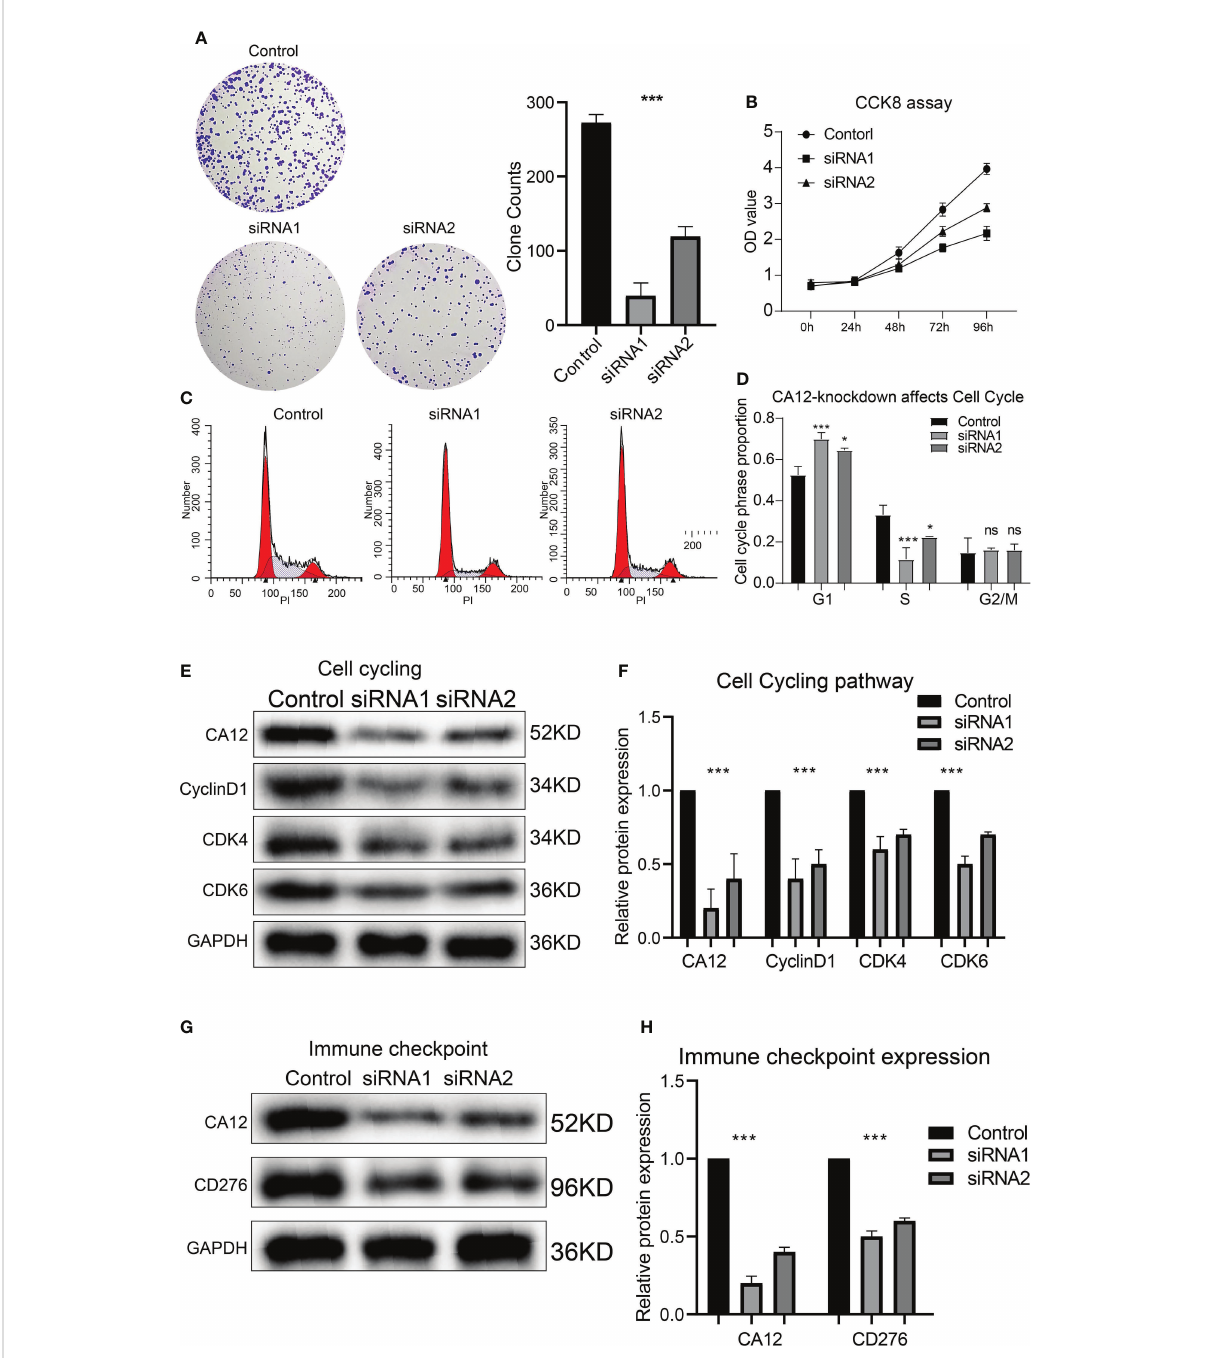
FIGURE 9 Roles of CA12 knockdown in UM cell growth and immune checkpoint expression. The images and the quanti fi cation results of clone formation assay (A) and the results of CCK8 assay (B) for the CA12-knockdown experiments. The cell cycle fl ow cytomatrix results (C) and the comparison of G1, S, and G2/M phases proportion (D) between control and siRNA-knockdown groups. The bands of G1 phase protein expressions (E) and their quanti fi cation comparison (F) between control and siRNA-knockdown groups. The bands of CD276 protein expression (G) and its quanti fi cation comparison (H) between control and siRNA-knockdown groups ns, *, *** means not statistically signi fi cant, p-value<0.05, and 0.001,